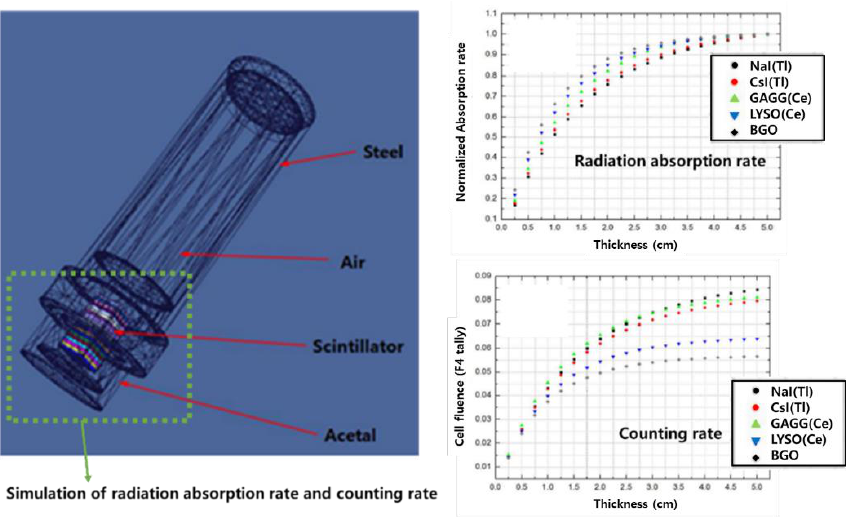
Figure 14. Simulation results of a radiation detector using MCNP6 simulation [35].